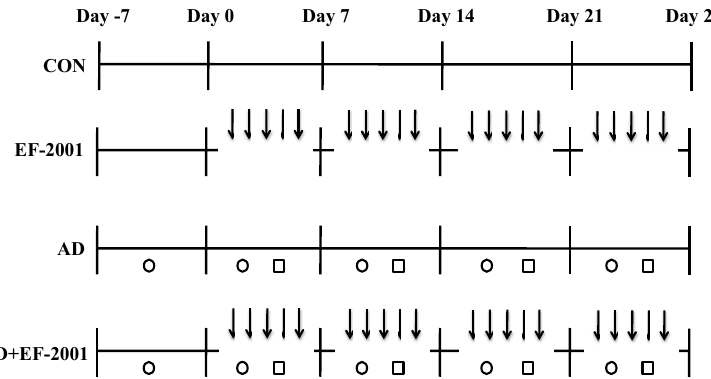
Figure 1. Experimental schedule for the induction of atopic dermatitis (AD) lesions. After seven days of initial boosting with 2,4 ‐ dinitrochlorobenzene (DNCB), DNCB and Dermatophagoides farinae extract (DFE) were applied to both ears once a week for four weeks. Starting at one week following the first induction, heat ‐ killed Enterococcus faecalis EF ‐ 2001 (EF ‐ 2001; 2 mg/kg) was orally administered daily for four weeks. ↓ , EF ‐ 2001; ○ , DNCB; □ , DFE; CON, control.